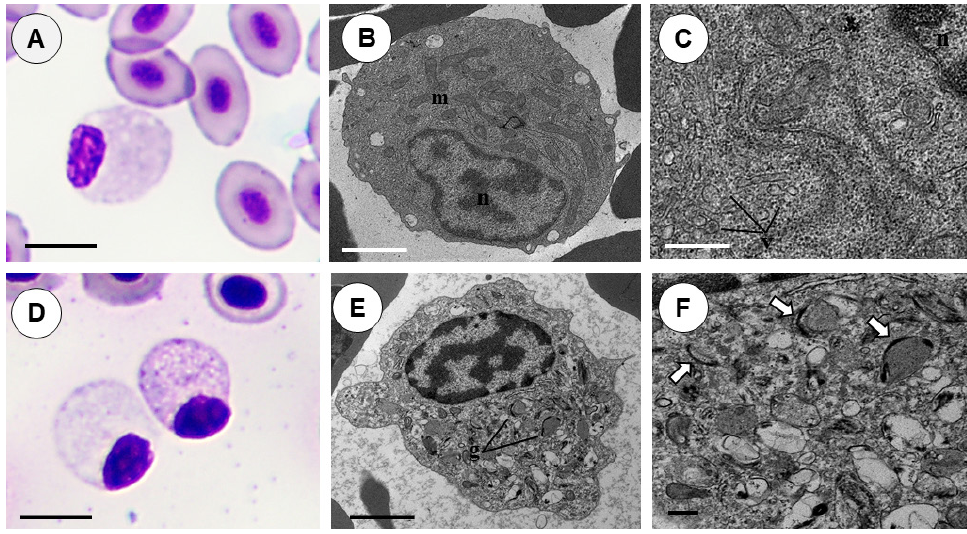
FIGURE 3 | Neutrophil and PAS-positive granular leukocytes in Pygocentrus nattereri from Brazilian Pantanal in light ( A and D ) and transmission electronic microscopy ( B , C , E , F ). A – C . Neutrophil with a lumpy nucleus and cytoplasmic vacuoles showing fine azurophilic and neutrophilic granulations. B . Mitochondria (m) and an extensive network of cell synthesis organelles are also observed; nucleus (n); C , vacuoles (v) and granules with varying size and electron density are observed. D – F . PAS-positive granular leukocyte with a displaced euchromatic nucleus; cytoplasm rich in small vacuoles and azurophilic granulation. In E and F , the granules content electrolytic material is observed (g), possibly with internal electrodense areas in an elongated half-moon shape (arrows). Scale bars = A and D = 10 µm (May Grunwald-Giemsa-Wright staining), B and E = 2 µm; C and F = 500 nm.